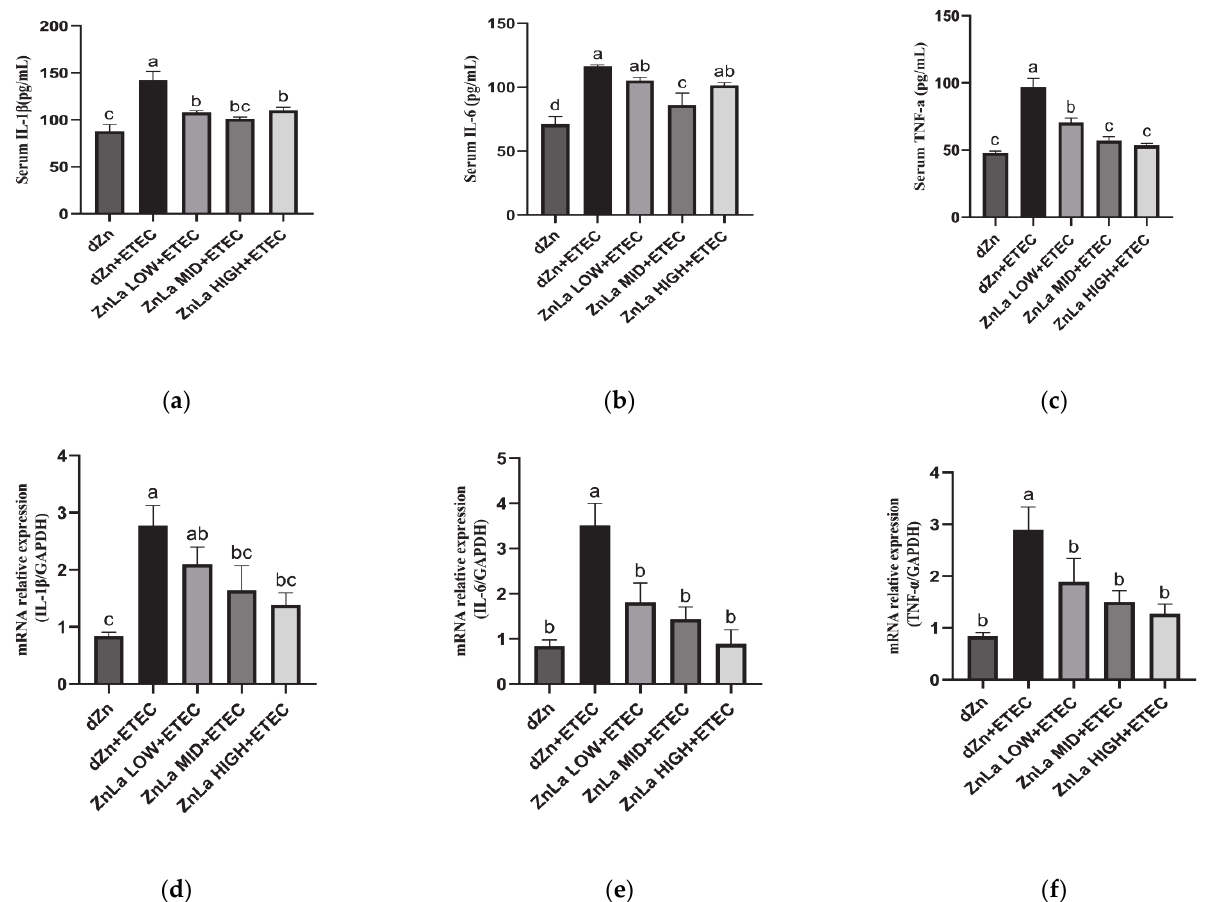
Figure 4. Effects of ZnLa on intestinal inflammation of mice with ETEC challenge. Serum levels of ( a ) IL-1 β , ( b ) IL-6, and ( c ) TNF- α . Relative mRNA expression of ( d ) IL-1 β , ( e ) IL-6 , and ( f ) TNF- α in the jejunum. The data are expressed as mean ± s.e.m (n = 9), and different lowercase letters in each group show significant differences ( p < 0.05).